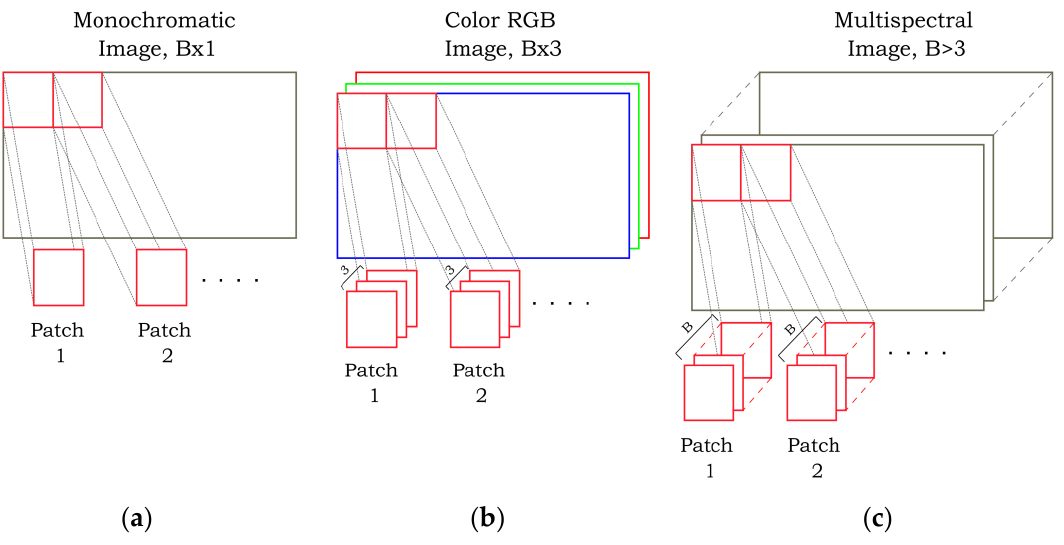
Figure 1. Patch extraction examples for various image types ( a ) in a monochromatic image, ( b ) in a color (RGB) image, and ( c ) in a multispectral image.